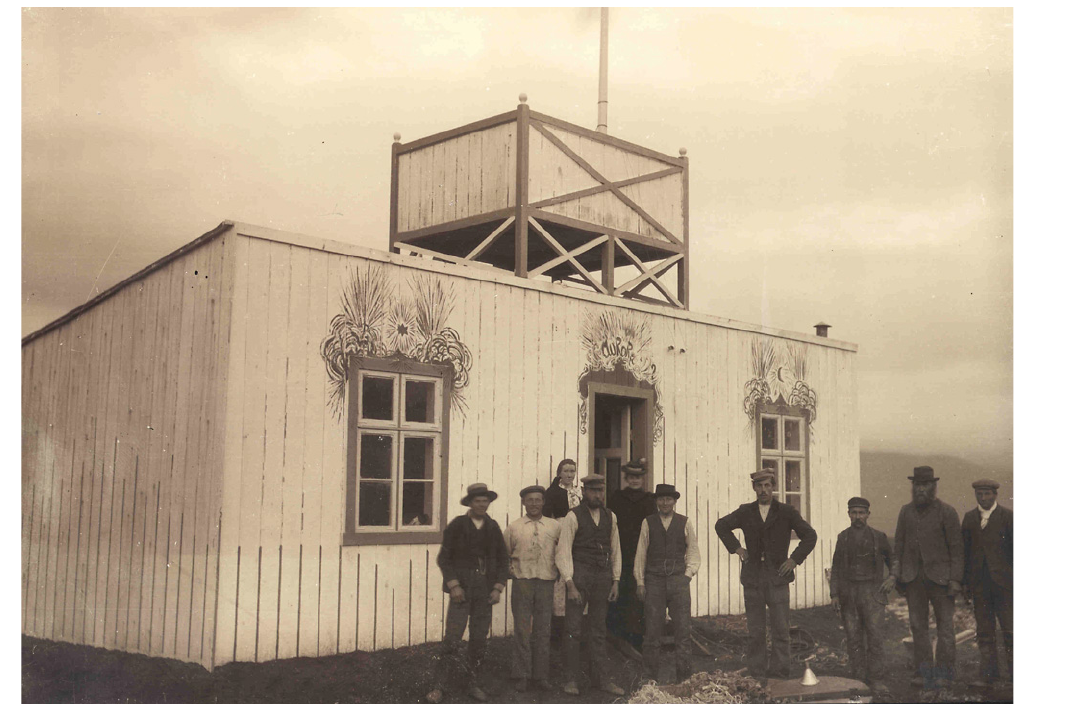
Figure 15. “Aurora”. Expedition base hut: Weather station, Painters studio, and Auroral observatory (Photo, DMI).